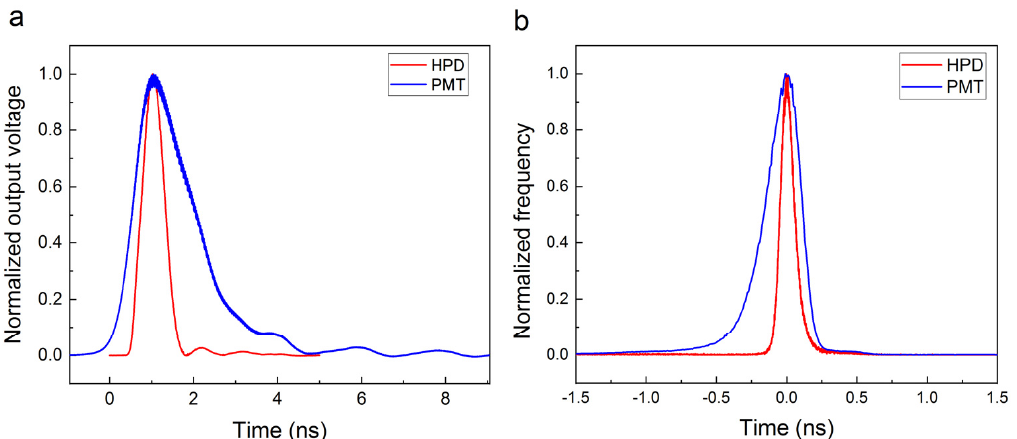
Figure 9. Time response characteristics of an HPD and a PMT [32]: ( a ) time response waveforms of an HPD and a PMT; ( b ) transit time spread (TTS) of an HPD and a PMT. The data were obtained using a pulse laser (wavelength = 405 nm) with a pulse width of 77 ps. The cathode supply voltage and the reverse voltage of HPD were − 8 kV and 390 V, respectively.